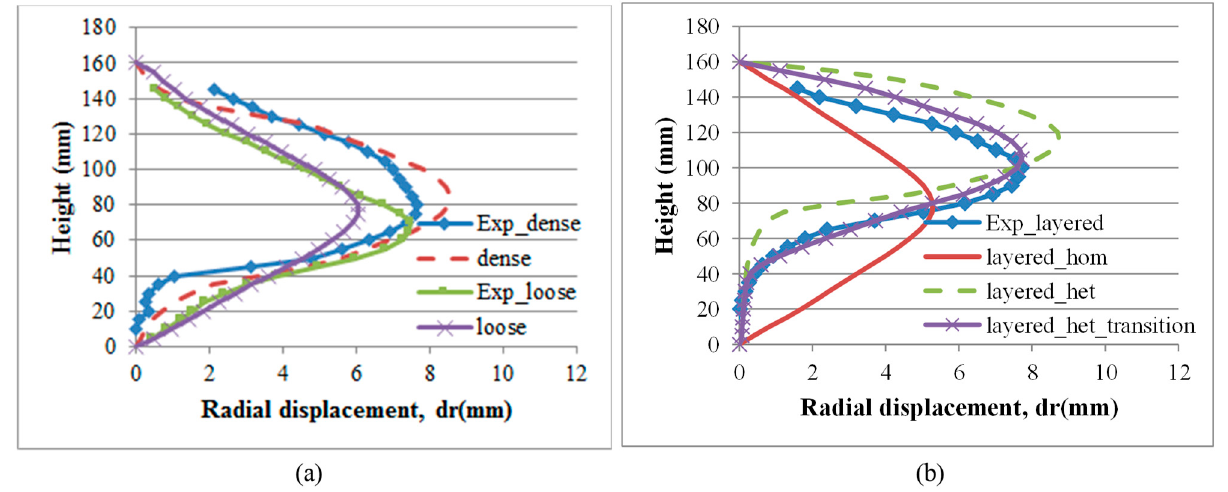
Figure 15. Radial displacement predictions ( a ) loose and dense specimens ( b ) layered specimen.